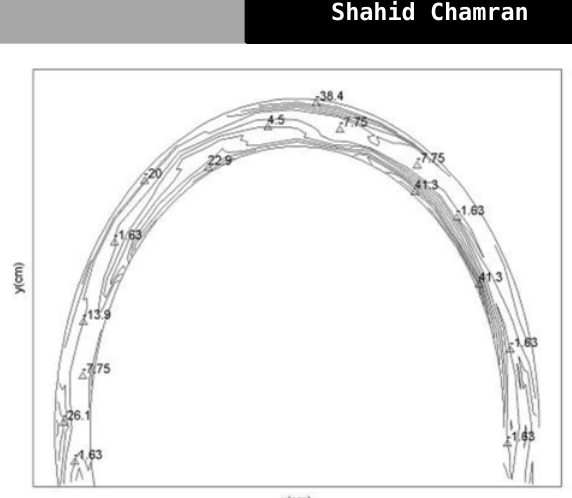
Fig. 13. Bed topography of 180 0 -bend without vanes installation.